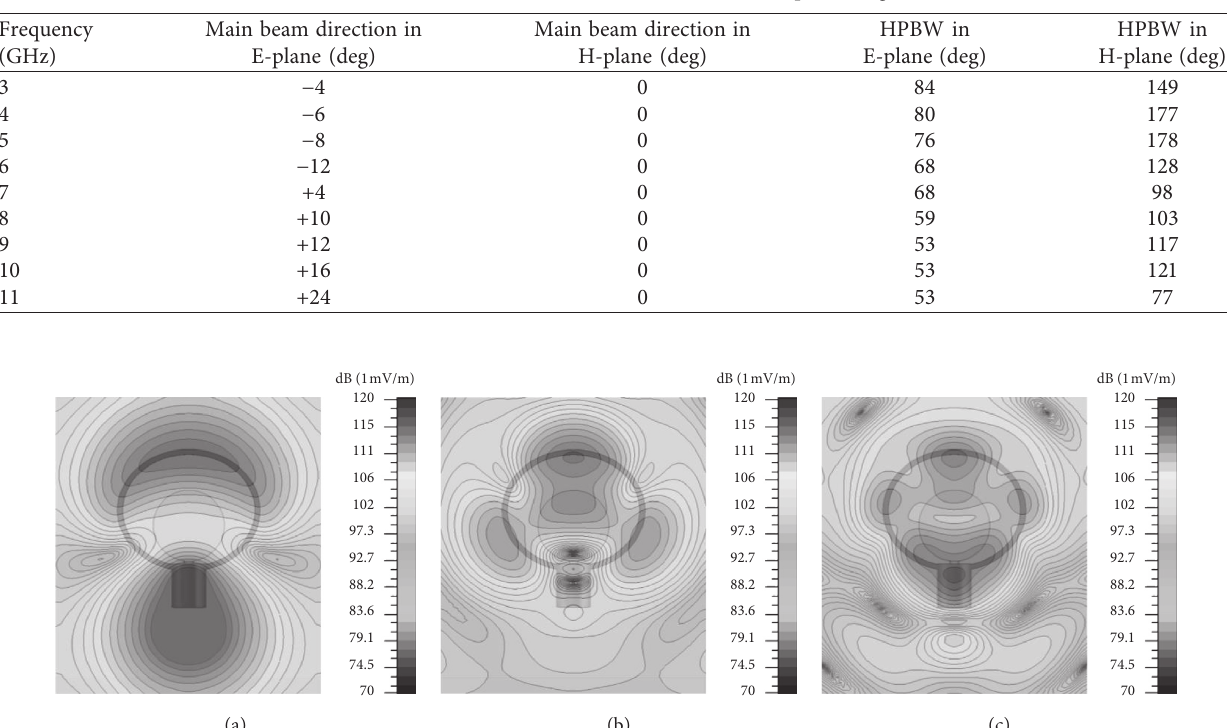
Figure 13: Radiation patterns of the antenna. (a) Antenna geometry (b) 3.1GHz. (c) 6.8GHz. (d) 10.6GHz. Table 2: Radiation characteristics of the CDM-excited elliptical ring antenna.